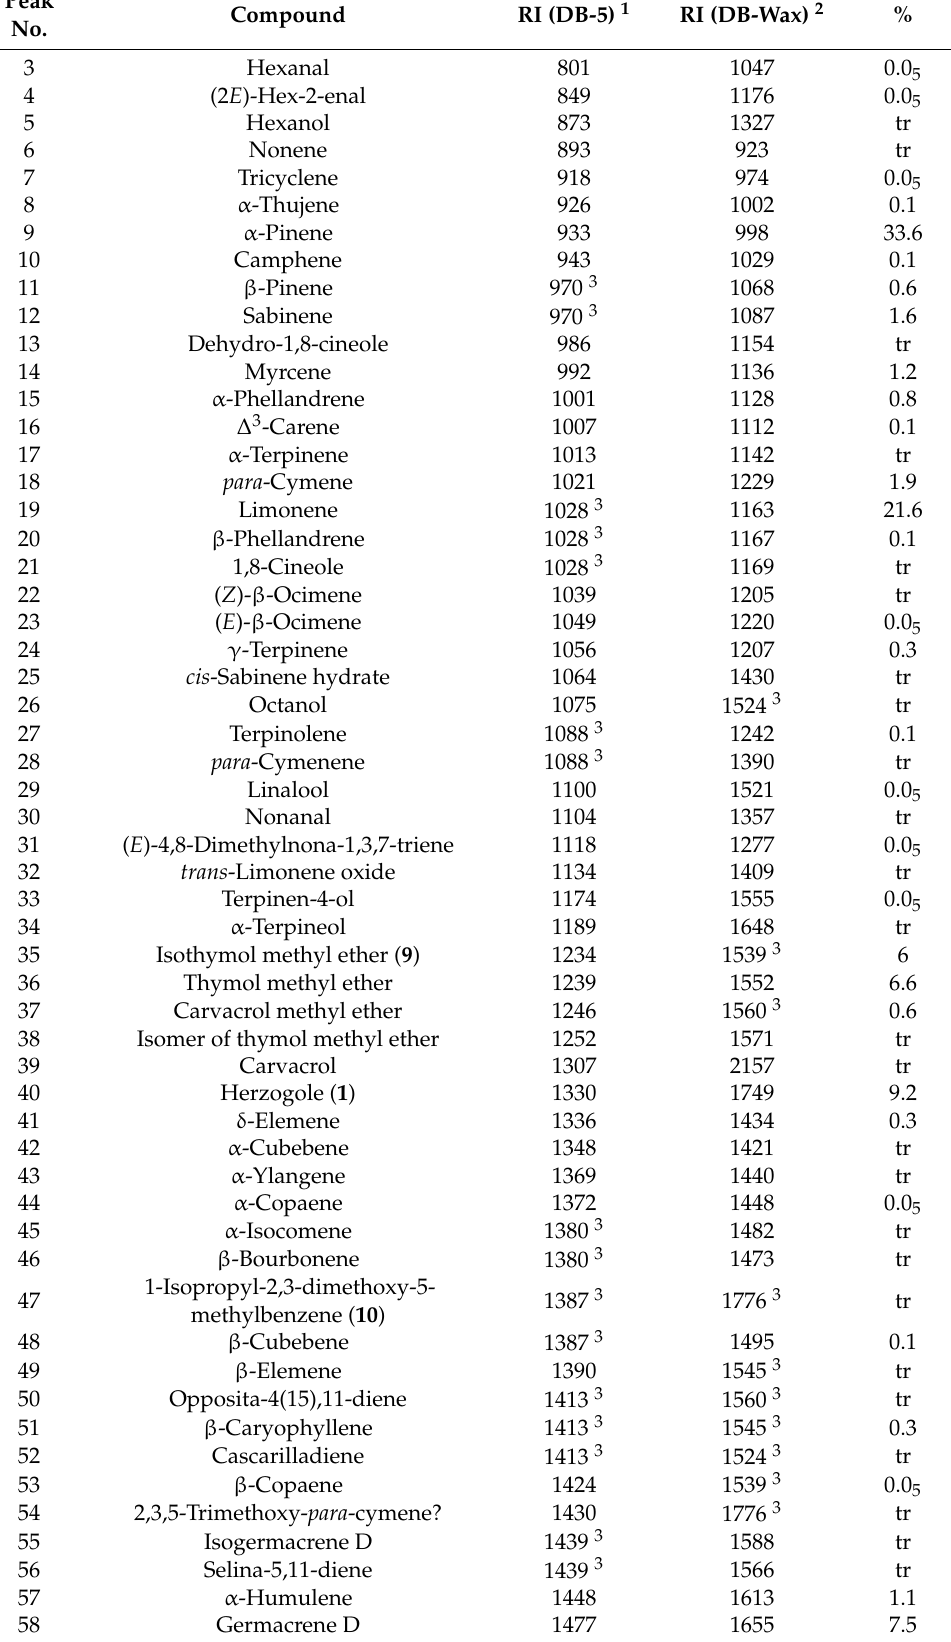
Table 1. Composition of the essential oil of the aerial part of Pentacalia herzogii from Bolivia.